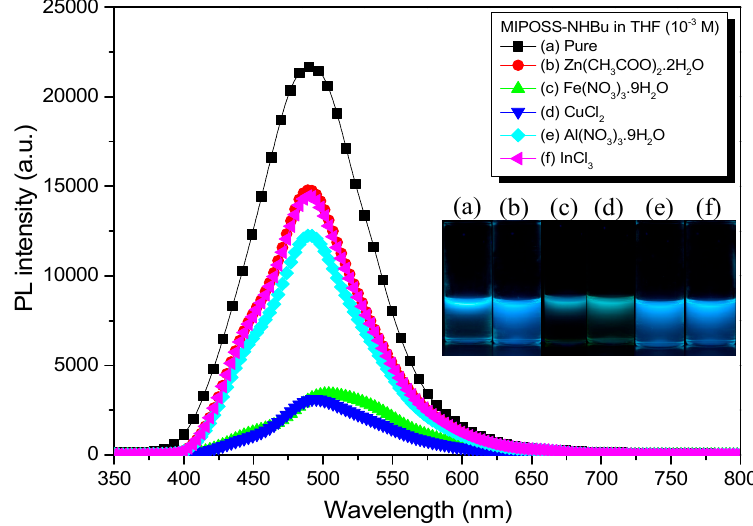
Figure 14. Fluorescence spectra (excitation: 330 nm) of the monomer MIPOSS-NHBu (concentration: 10 − 3 M) in the presence of various metal ions: ( a ) pure MIPOSS-NHBu; ( b ) Zn(CH 3 COO) 2 ·2H 2 O; ( c ) Fe(NO 3 ) 2 ·9H 2 O; ( d ) CuCl 2 ; ( e ) Al(NO 3 ) 3 ·9H 2 O; and ( f ) InCl 3 .